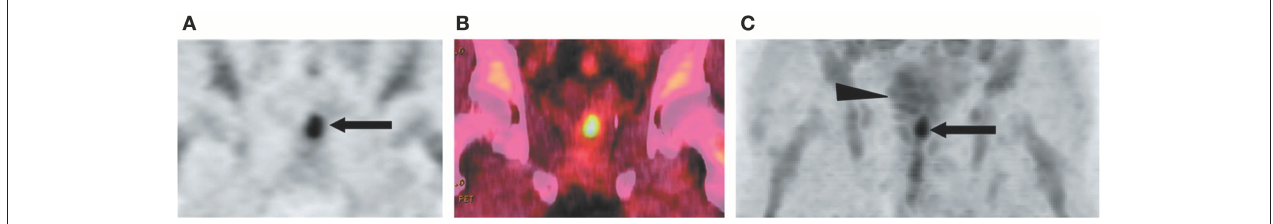
FIGURE 7 | 18 F-FACBC PET images of a 71-year-old man with biopsy-proven prostate bed recurrence. (A) Coronal PET and (B) coronal fused PET/CT image illustrated the recurrent tumor extending toward left seminal vesicle (arrow in A). (C) Maximum-intensity-projection image at 20min illustrated high uptake in prostate bed (arrow) with little bladder excretion (arrowhead). This figure is reproduced with permission from Schuster et al. (2007), Figure 4 © by the Society of Journal of Nuclear Medicine, Inc.